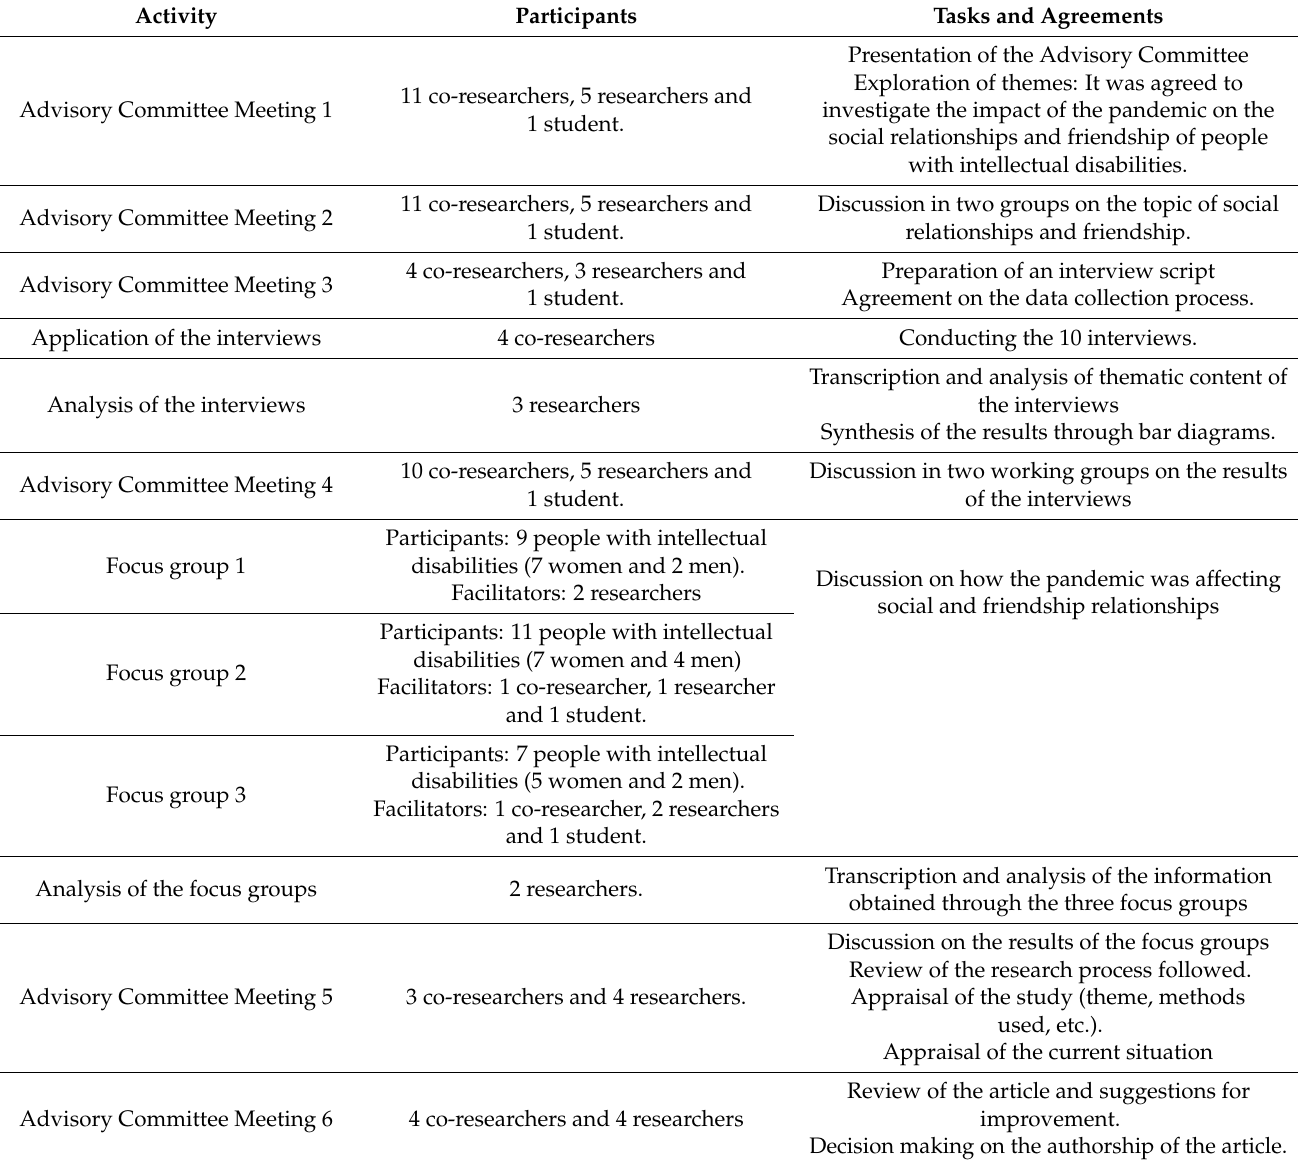
Table 2. Synopsis of the process followed to carry out the research and prepare the